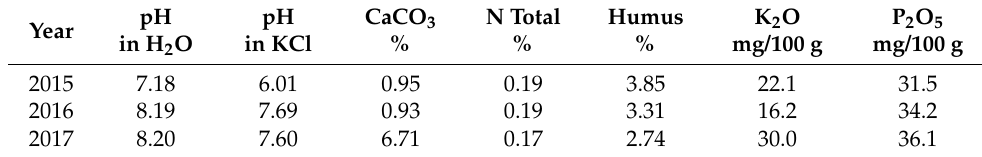
Table 1. Chemical properties of soil.